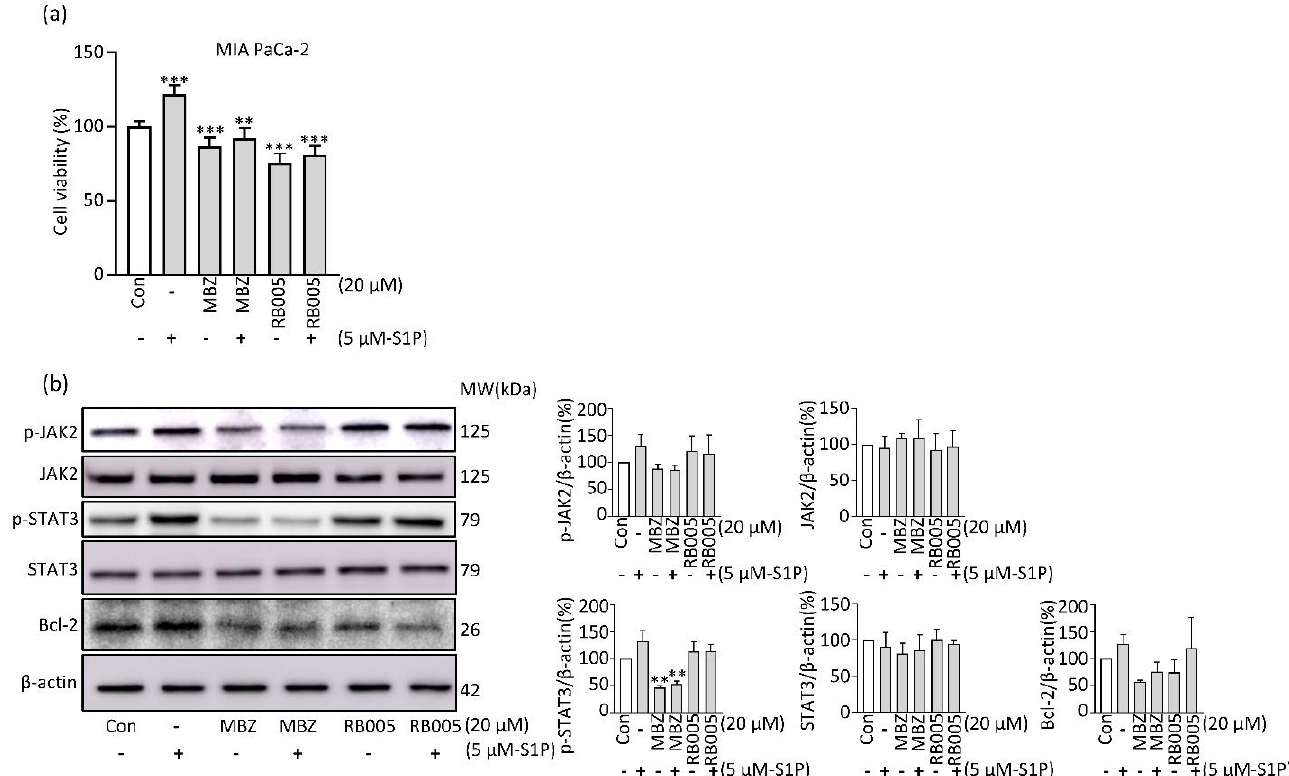
Figure 4. S1P treatment partially reverse the effect of MBZ in PDAC: ( a ) percentage of cell viability in MIA PaCa-2 cells was calculated using 20 µ M MBZ, RB005 and combination with 5 µ M S1P; ( b ) Western blotting was performed to detect markers related to the JAK2/STAT3/Bcl-2 signaling pathway in PDACs treated with or without 5 µ M S1P. Results were quantified by using ImageJ and each experiment was performed independently three times. The data were depicted on mean ±